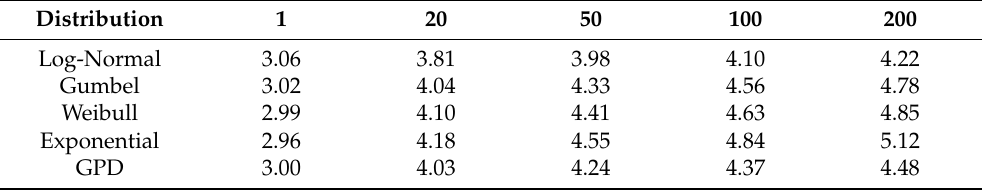
Table 3. Wave height predictions (m) for different return periods.